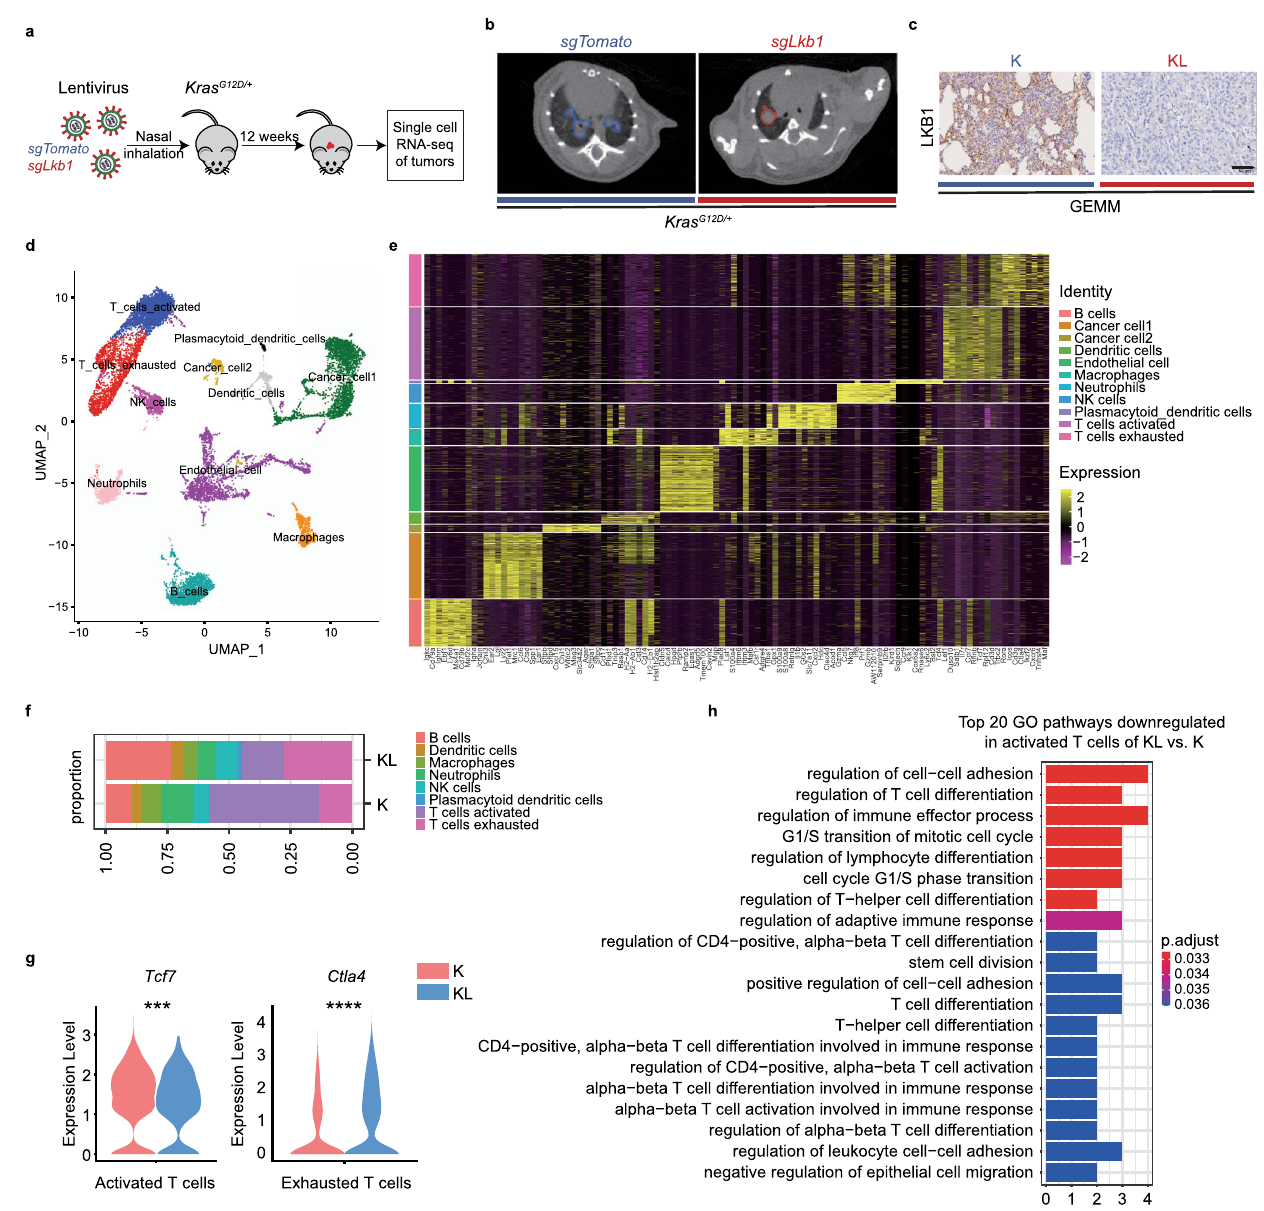
Fig. 1 | Mutant Kras/Lkb1 driven lung cancer cell atlas was established. a Schematic illustration for generation of the genetically engineered Kras -driven mouse model to establish Kras G12D/+ mice with conditional knockout of Lkb1 . b Micro-CT scan of the mouse lung. Left: Kras G12D/+ sg Tomato (K) mouse. Right: Kras G12D/+ sg Lkb1 (KL)mouse. c IHCstainingofLKB1inmouselungtumorsectionsin K and KL mouse. Scalebar, 50 μ m (40×). n =1 experiment with n =5 mice. d UMAP plot of 14,260 cells from lung tumor samples of K ( n =1) and KL ( n =1) mouse, colored by their 11 major celltypes. e Heatmap of canonical cell-type markers of 11